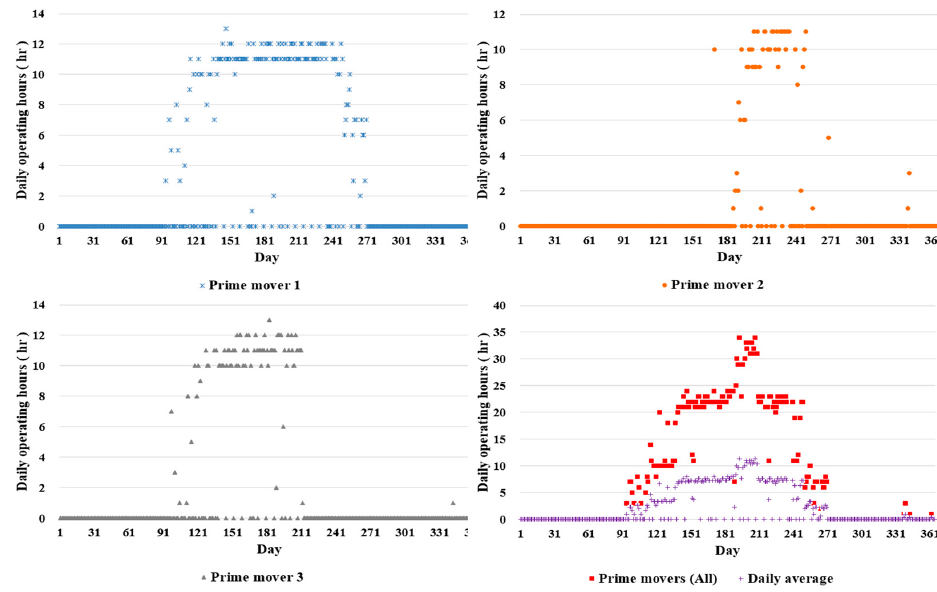
Figure 8. Annual daily operation hours of prime movers for Case B.